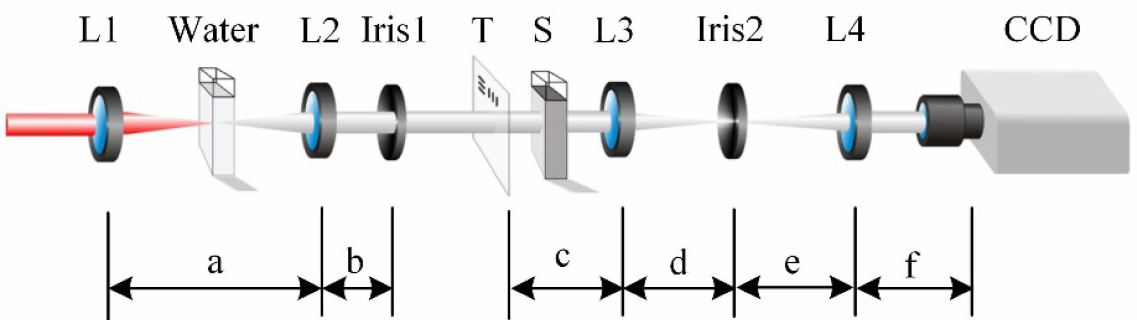
Figure 1. Schematic setup for imaging through turbid medium. L, lenses; T, resolution test chart; S, scattering medium (suspension of polystyrene spheres with particle size of 3.13 µ m). The distances between components are as follows: a, 250 mm; b, 10 mm; c, 160 mm; d, 160 mm; e, 200 mm; f, 200